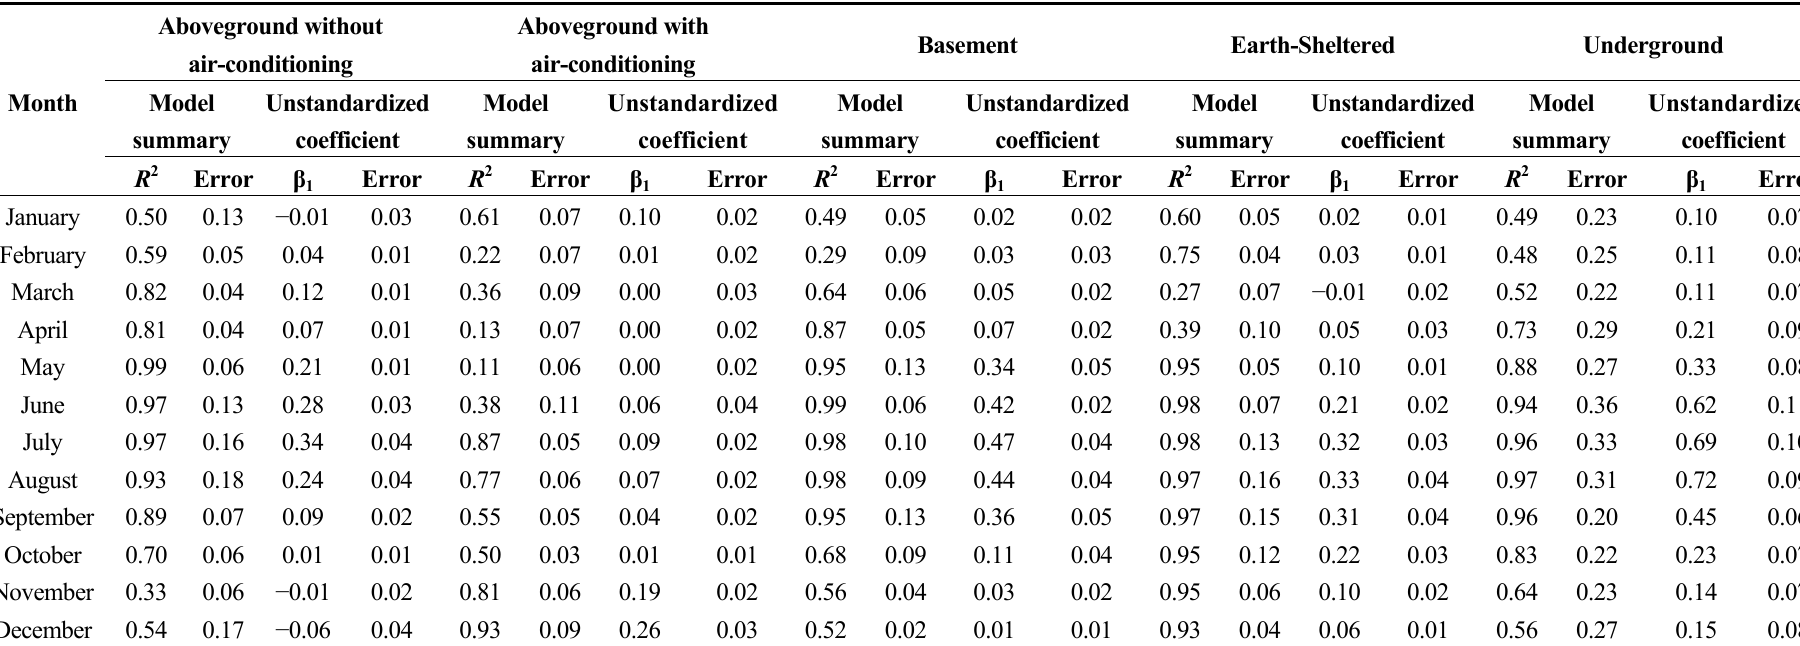
Table 1. Results and coefficients of the linear regression model: model summary ( R 2 and Std. Error of the estimation), and unstandardized coefficients ( β and Std. Error of the 1